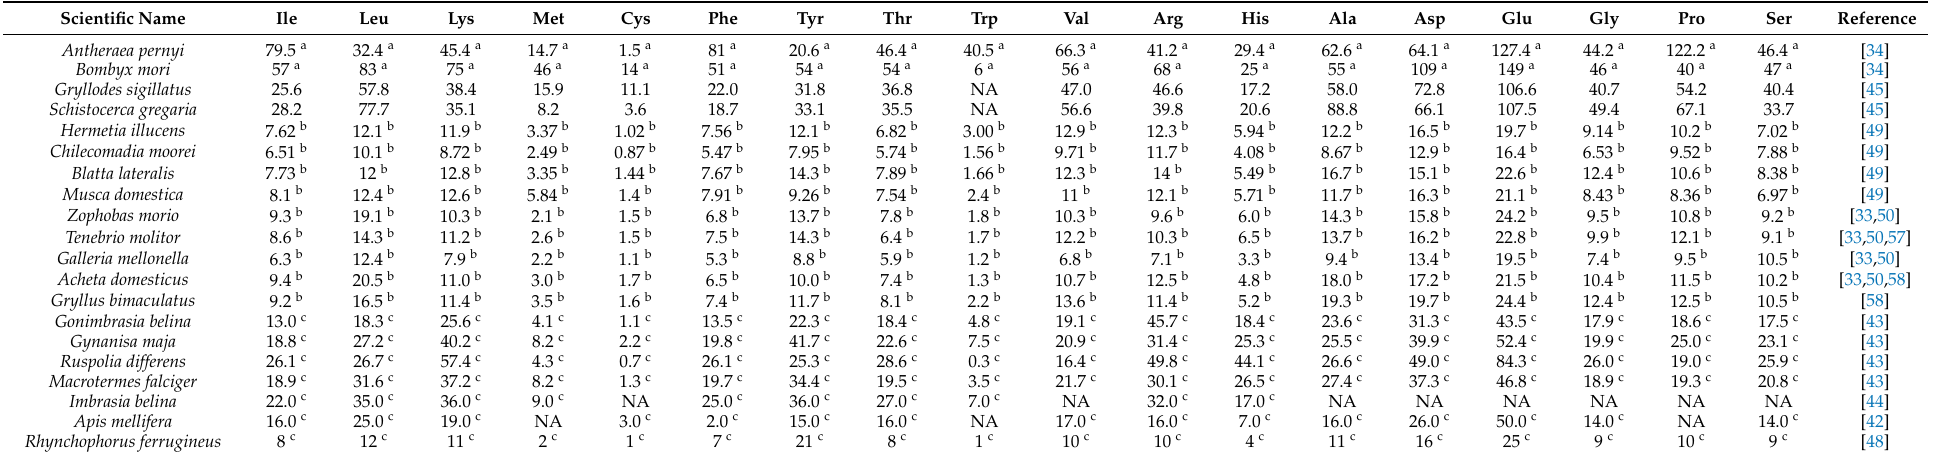
Table 2. Amino acid composition of insects.